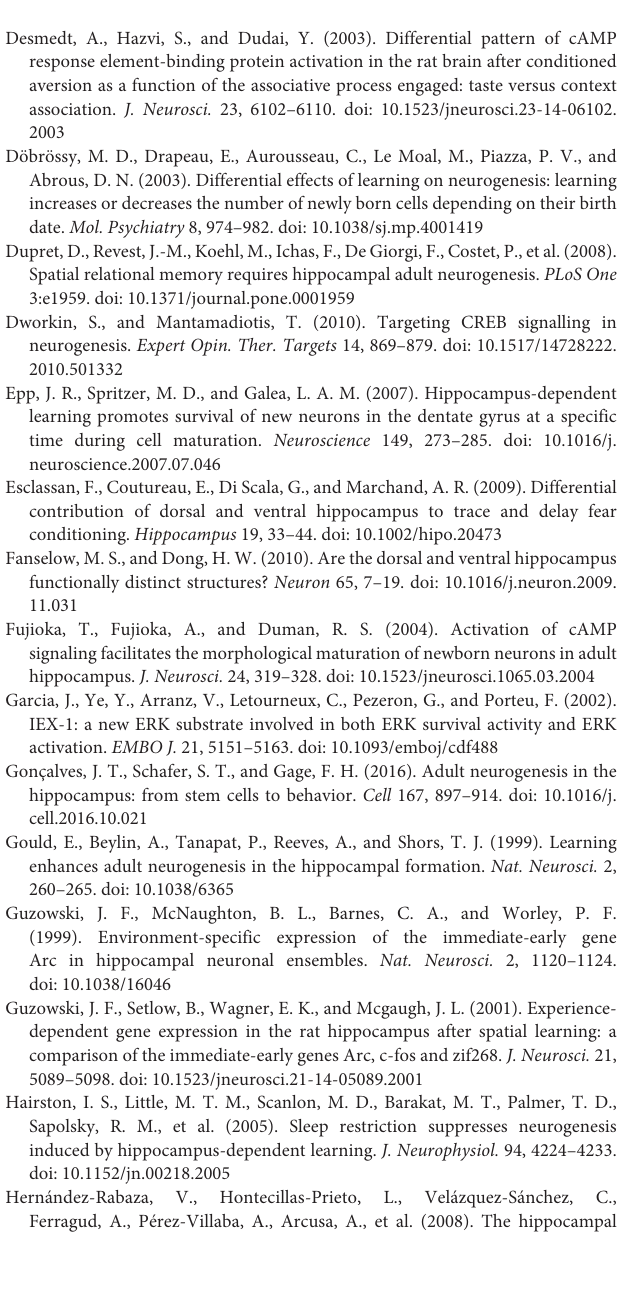
delay-conditioned ( n = 3) and trace-conditioned animals ( n = 3). There was significant increase in the number of BrdU +ve cells (* p < 0.05; F (2,8) = 5.67), Ki67 +ve cells (* p < 0.05; F (2,8) = 6.58), and BrdU +ve and Ki67 +ve double-labeled cells (* p < 0.05; F (2,8) = 7.73) in the trace-conditioned animals (one-way ANOVA followed by Tukey post hoc ), compared to the un-conditioned control animals. The numbers of BrdU +ve cells, Ki67 +ve cells and BrdU +veand Ki67 +ve double-labeled cells in the delay-conditioned animals were comparable to the un-conditioned control animals. n.s., non-significant. FIGURE S2 | Number of BrdU +ve cells in the SVZ of the trace- ( n = 3), delay- ( n = 3), and un-conditioned ( n = 3) animals. BrdU +ve cells are shown as green dots in histological photomicrographs (10 × ) of (A) un-conditioned, (B) trace-conditioned, and (C) delay-conditioned animals. (D) The number of BrdU +ve cells/mm 3 area did not change significantly in the SVZ after delay- and